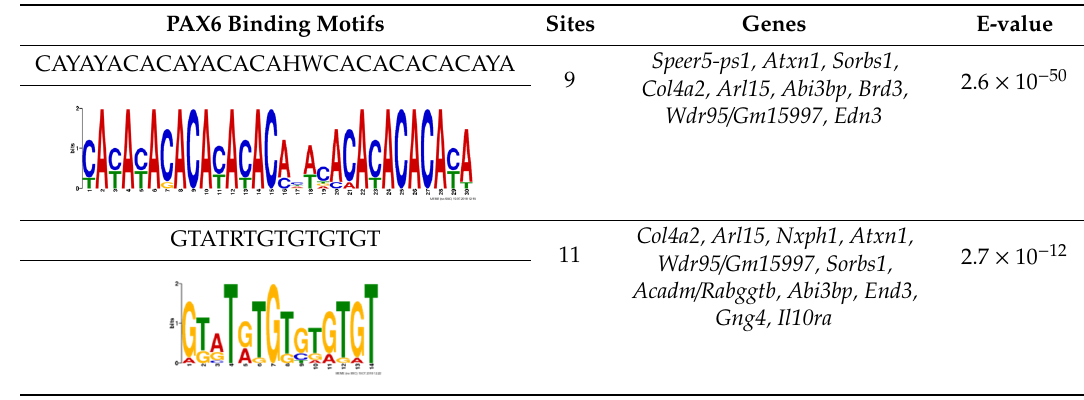
Table 2. PAX6 DNA-Binding Motifs Recognized Within the PAX6 Binding Regions by MEME-ChIP Tool.